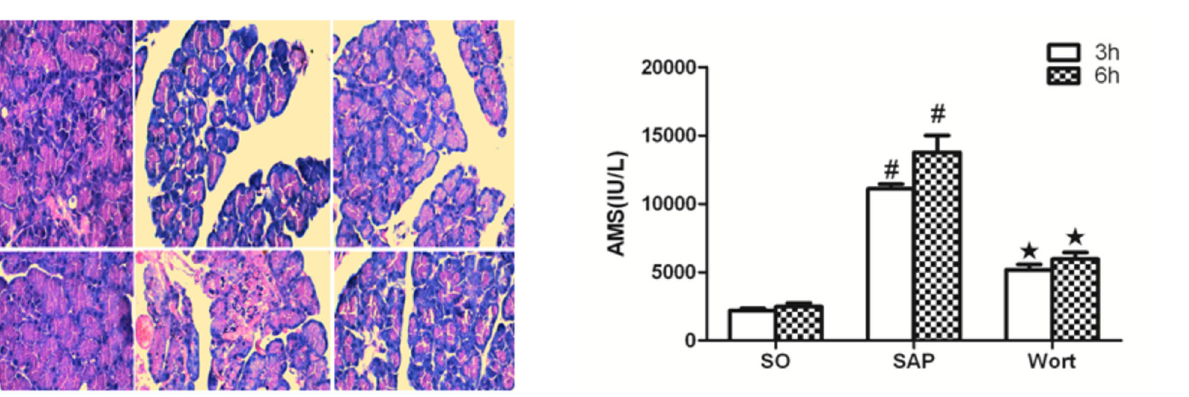
Figure 3. Serum amylase in each group at the 3 h and 6 h time point. # P <0.05 vs. SO group; ★ P <0.05 vs. SAP group.